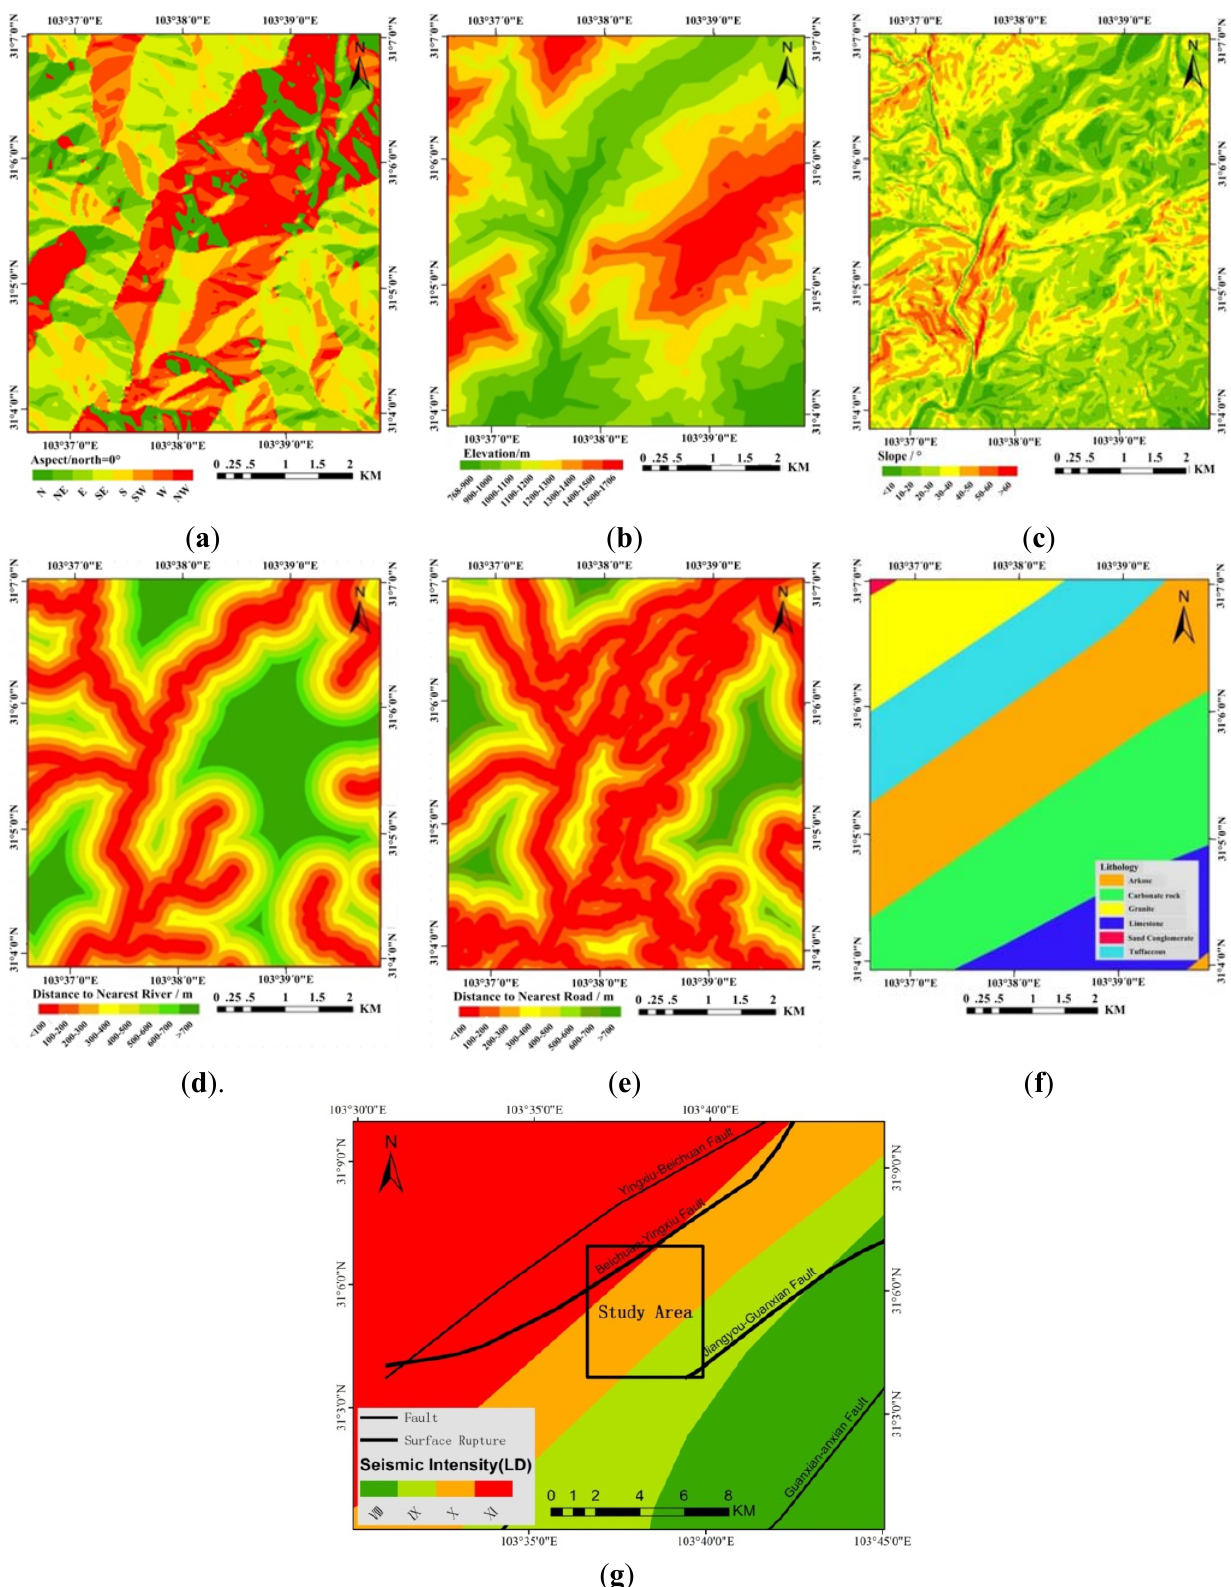
Figure 4. The topographical ( a – e ), geological ( f ), and seismic ( g ) factors for landslides in the study area. (a) Aspect; (b) Elevation; (c) Slope; (d) Distance to nearest river; (e) Distance to nearest road; (f) Lithology; (g) Seismic